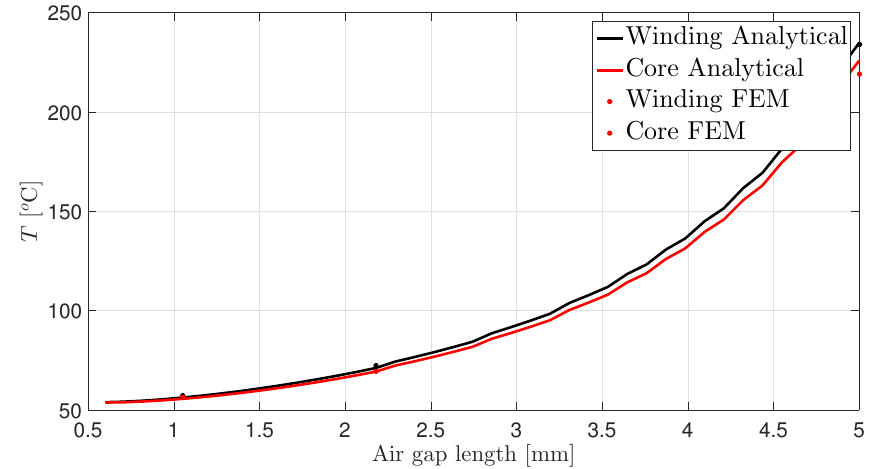
Figure 10. The winding and the core temperature variation with the air gap